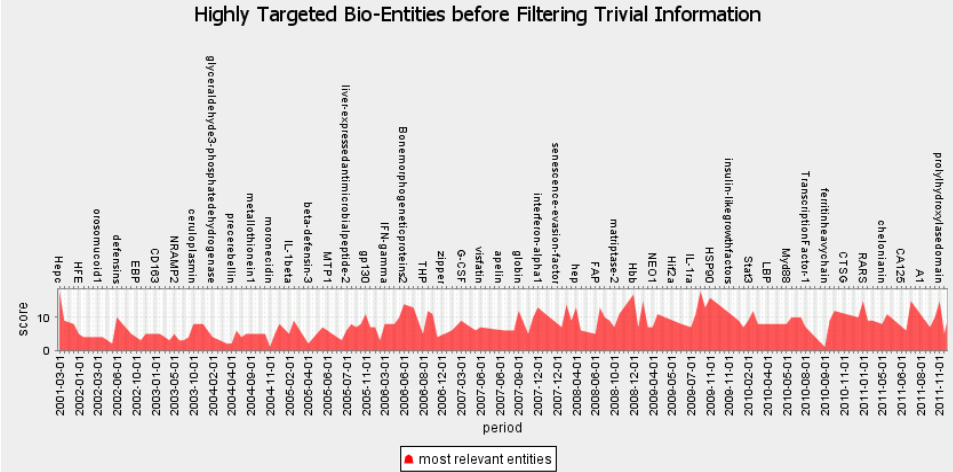
Figure 10. Highly scored proteins over the Hepcidin decade after filtering the background